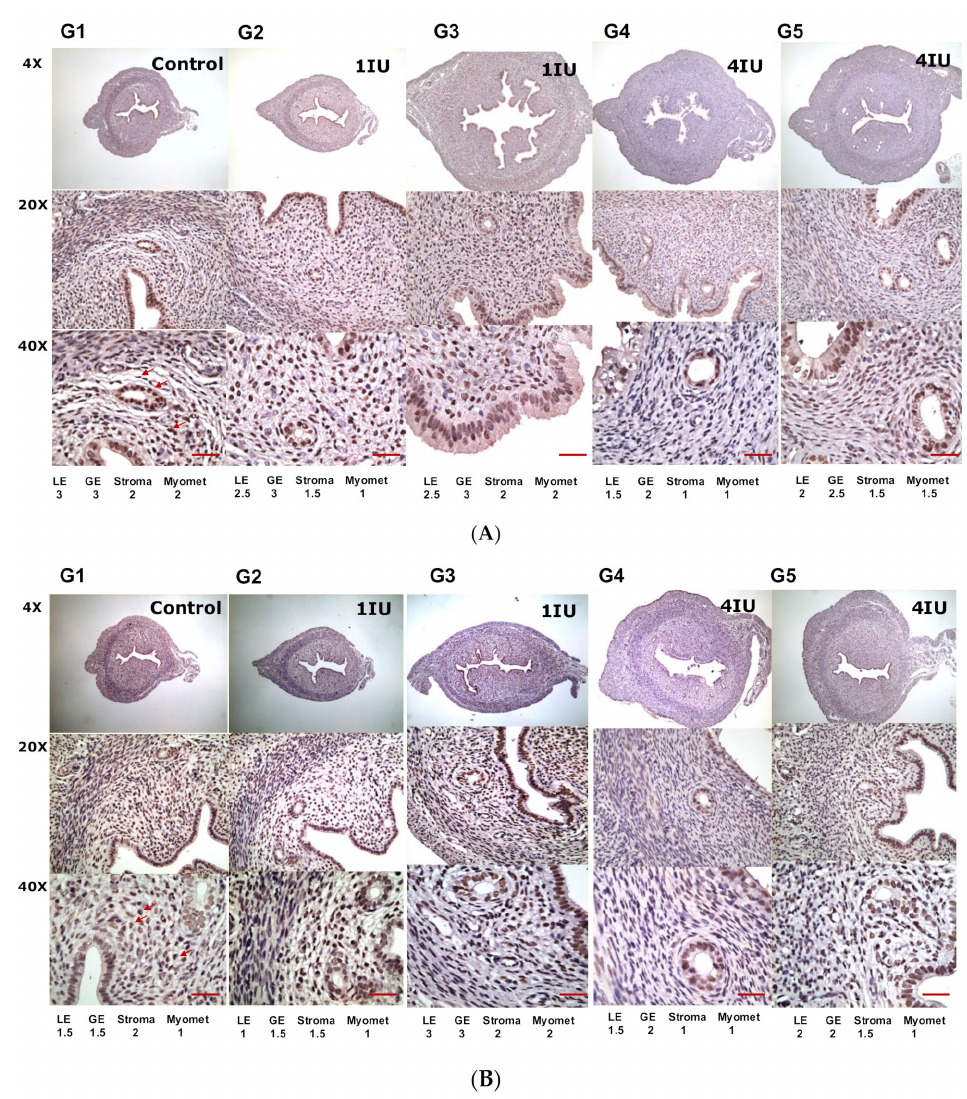
Figure 4. The expression of estradiol receptors and progesterone receptors in the uterus of rats after rhFSH treatment. For the detection of ( A ) estradiol receptor and ( B ) progesterone receptor by immunohistochemical staining. The degrees of staining were categorized as follows: (0), no staining; (1), faint staining; (2), moderate staining; and (3), strong staining. Arrows pinpointed the staining of ER or PR. Scale bar = 500 µ m. G1: abdominal s.c. injection of normal saline twice daily for 4 days (days 1 to 4); G2: abdominal s.c. injection of rhFSH (1 IU) twice daily for 4 days (days 1 to 4); G3: vaginal s.c. injection of rhFSH (1 IU) twice daily for 4 days (days 1 to 4); G4: abdominal s.c. injection of rhFSH (4 IU) every other day (two injections) (days 1 & 3); G5: vaginal s.c. injection of rhFSH (4 IU) every other day (two injections) (days 1 & 3). Abbreviations: LE: luminal endometrium; GE: glandular endometrium; Myomet: